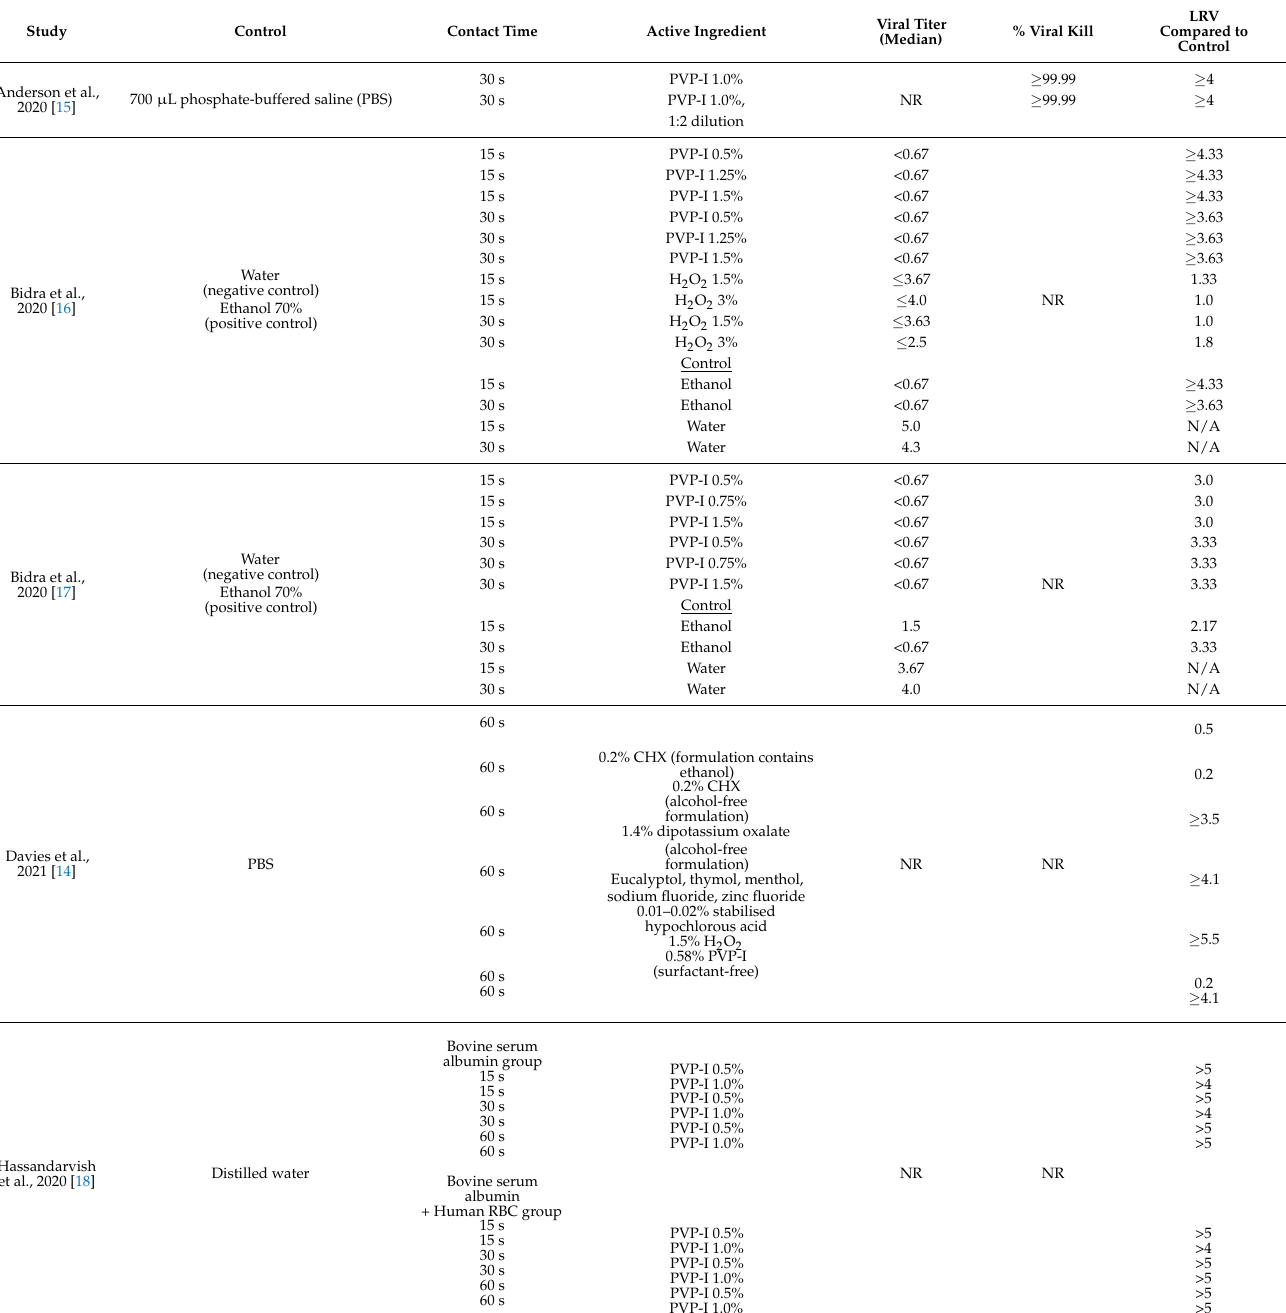
Table 1. In-vitro studies on the virucidal effects of mouthwash on